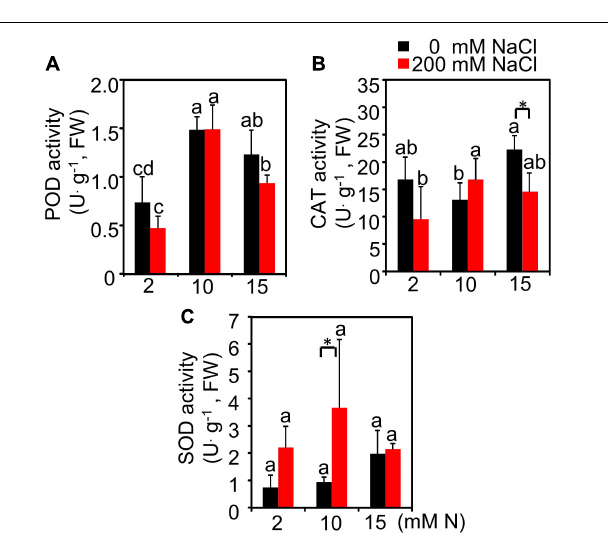
FIGURE 3 | Effect of nitrogen application on the antioxidant enzyme activities of bermudagrass under control and salt treatment. POD activity (A) , CAT activity (B) , and SOD activity (C) in the leaves of plants grown with different nitrogen concentrations (2, 10, and 15 mM N) exposed to control (0 mM NaCl) and salt treatment (200 mM NaCl), respectively. Different letters above the columns indicate statistically significant differences at P < 0.05 under different N levels with the same NaCl level by Tukey’s test. ∗ Shows significant differences ( P < 0.05) under 200 mM NaCl treatment and 0 mM NaCl condition with the same N level by Tukey’s